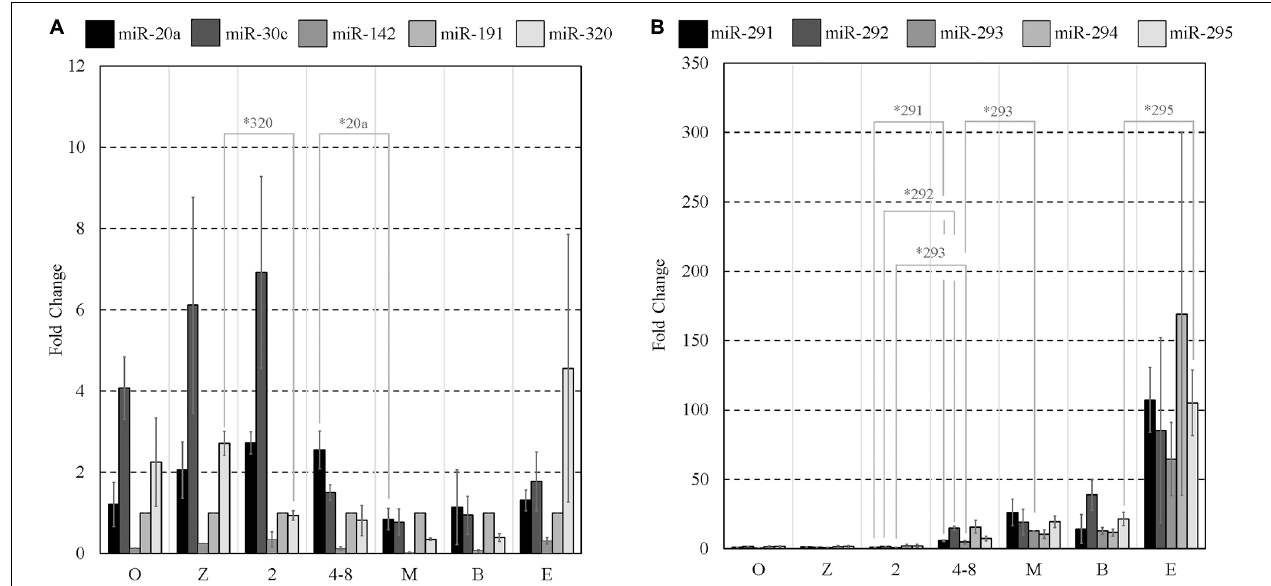
FIGURE 1 | Mature miRNA expression of select sequences from MII oocytes and staged pre-implantation embryos from zygote through to the expanded blastocyst stage. Expression of panels (A,B) miRNAs are normalized to endogenous miR-191. Each data point represents the combined expression of 10 MII oocytes or embryos removed from an ongoing in vitro group culture at designated time points after morphological staging. MII oocytes were collected along with presumptive zygotes 15 h post-hCG. n = 3, error bars = SEM. ∗ p < 0.05; only significant differences are labeled.